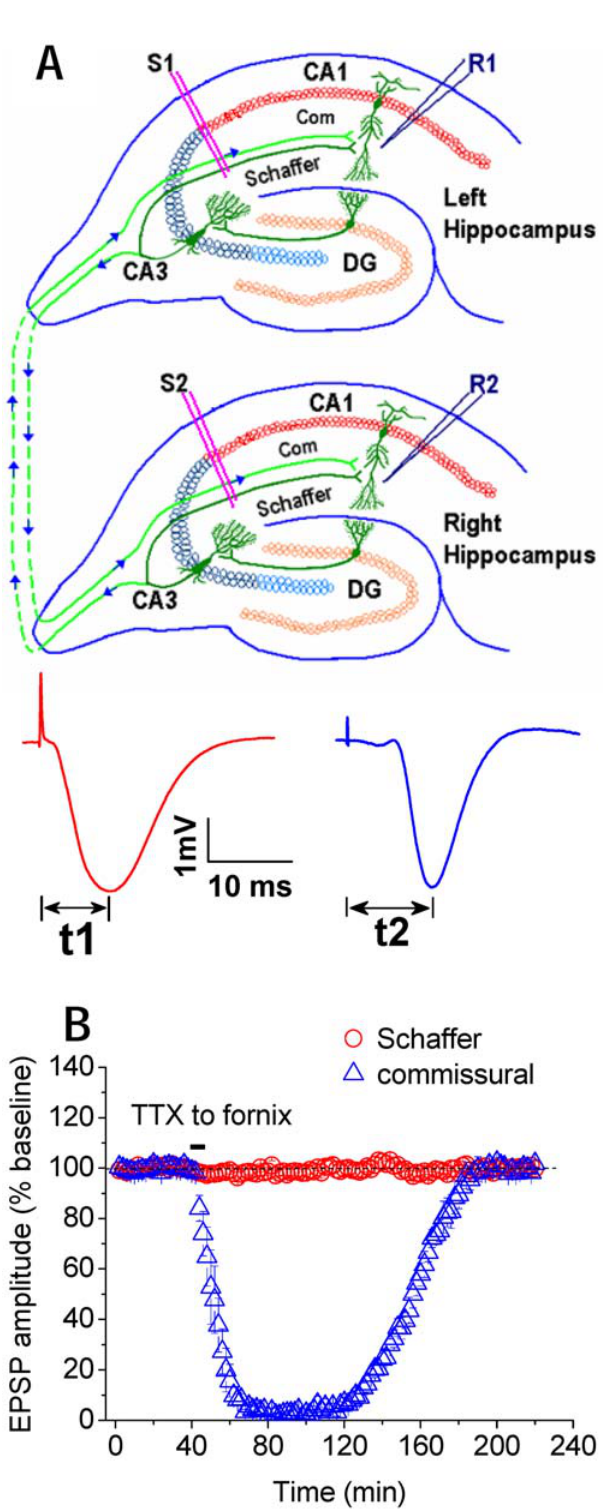
Figure 1. Schaffer and commissural pathways in CA3-CA1 network. A , Recording electrode (R1) in CA1 stratum radiatum records field excitatory postsynaptic potentials (fEPSPs) in response to stimulation of ipsilateral Schaffer (S1) and contralateral commissural pathway (S2) at stratum radiatum, respectively. Schaffer=Schaffer collaterals; Com=commissural fibers. B , Peak latency of Schaffer fEPSP (t1) is about 5 ms shorter than that of commissural fEPSP (t2). Timing window ( D t) between Schaffer and commissural inputs is calculated